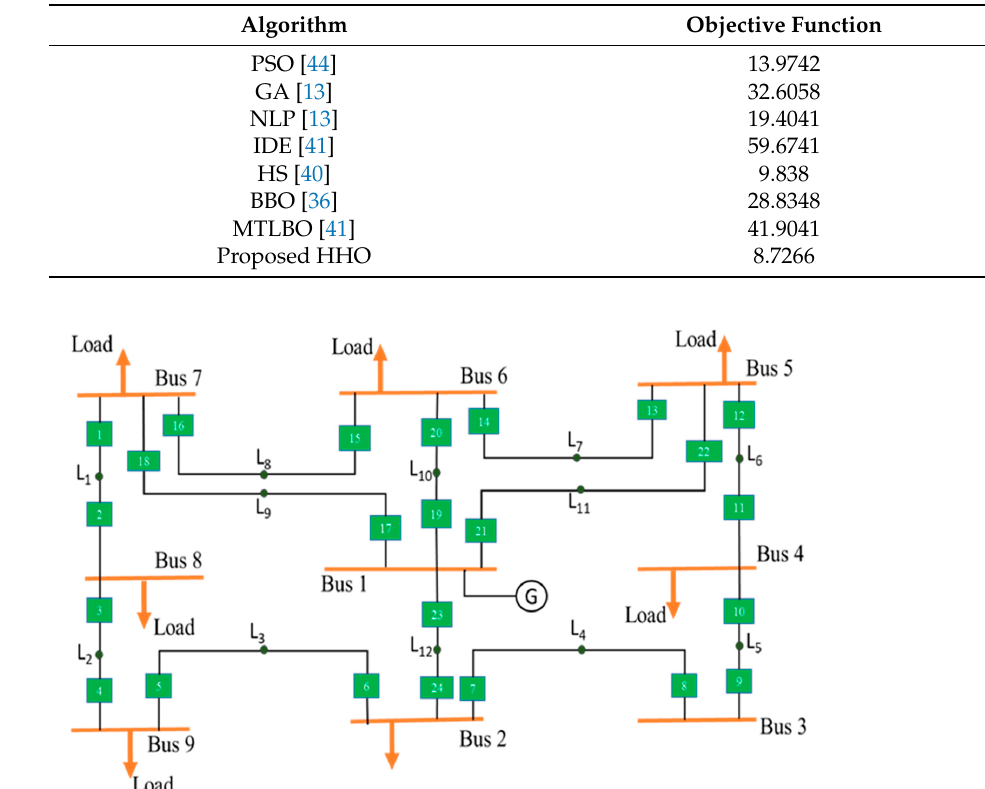
Figure 7. Single line diagram of the IEEE 9 bus system. Table 2. Optimum value of TDS for the IEEE 9 bus system.